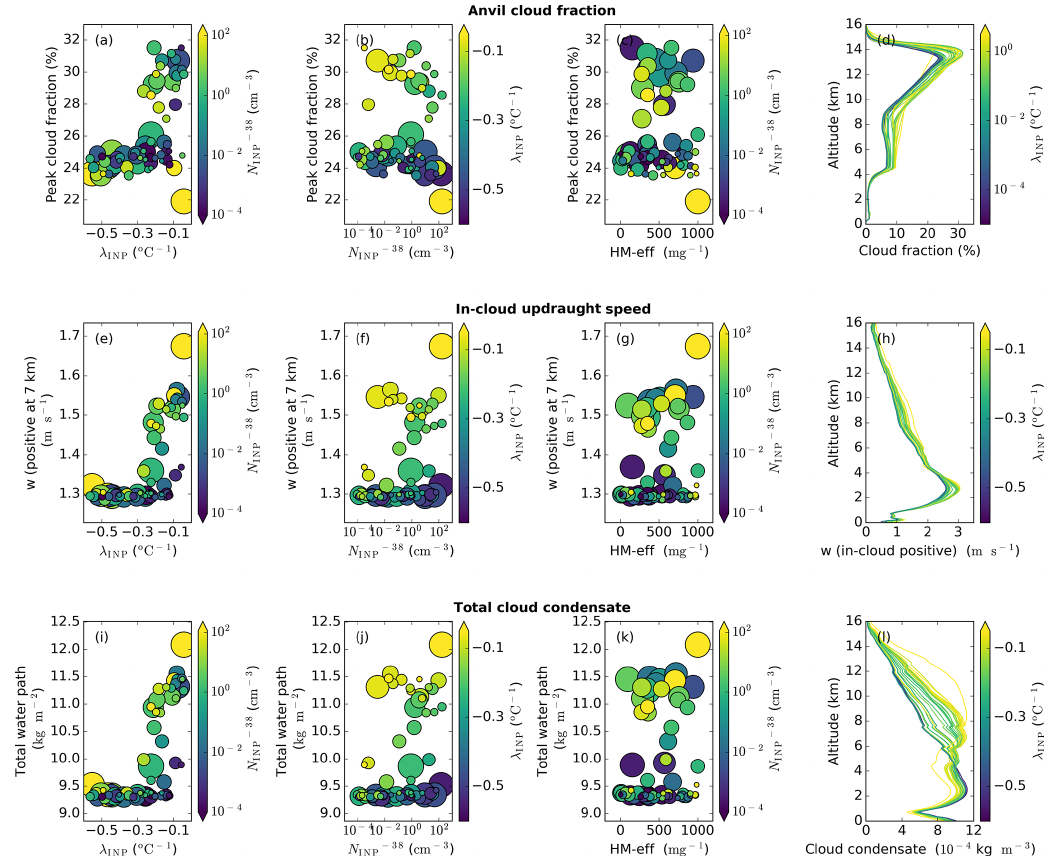
Figure 12. Anvil cloud fraction and driving processes. Dependence of anvil cloud fraction (a–d) , in-cloud updraught speed at 7km (e–h) , and total cloud condensate (i–l) on the three uncertain input parameters: λ INP (a, e, i) , N INP − 38 (b, f, j) , and HM-eff (c, g, k) . In-cloud profiles of anvil cloud fraction (d) , in-cloud updraught speed (h) , and total cloud condensate (l) in all simulations are coloured by λ INP . For panels (a) , (e) , and (i) the colour of the markers indicates N INP − 38 and the marker size indicates the HM-eff. For panels (b) , (f) , and (j) the colour of the markers indicates λ INP and the marker size indicates HM-eff. For panels (c) , (g) , and (k) the colour of the markers indicates N INP − 38 and the marker size indicates λ INP . Panels (a) – (d) are the average of the cloud property between 150 and 240min (anvil stage) in the simulation, while panels (e) – (l) are the average of the relevant cloud property between 60 and 180min (convective stage) in the